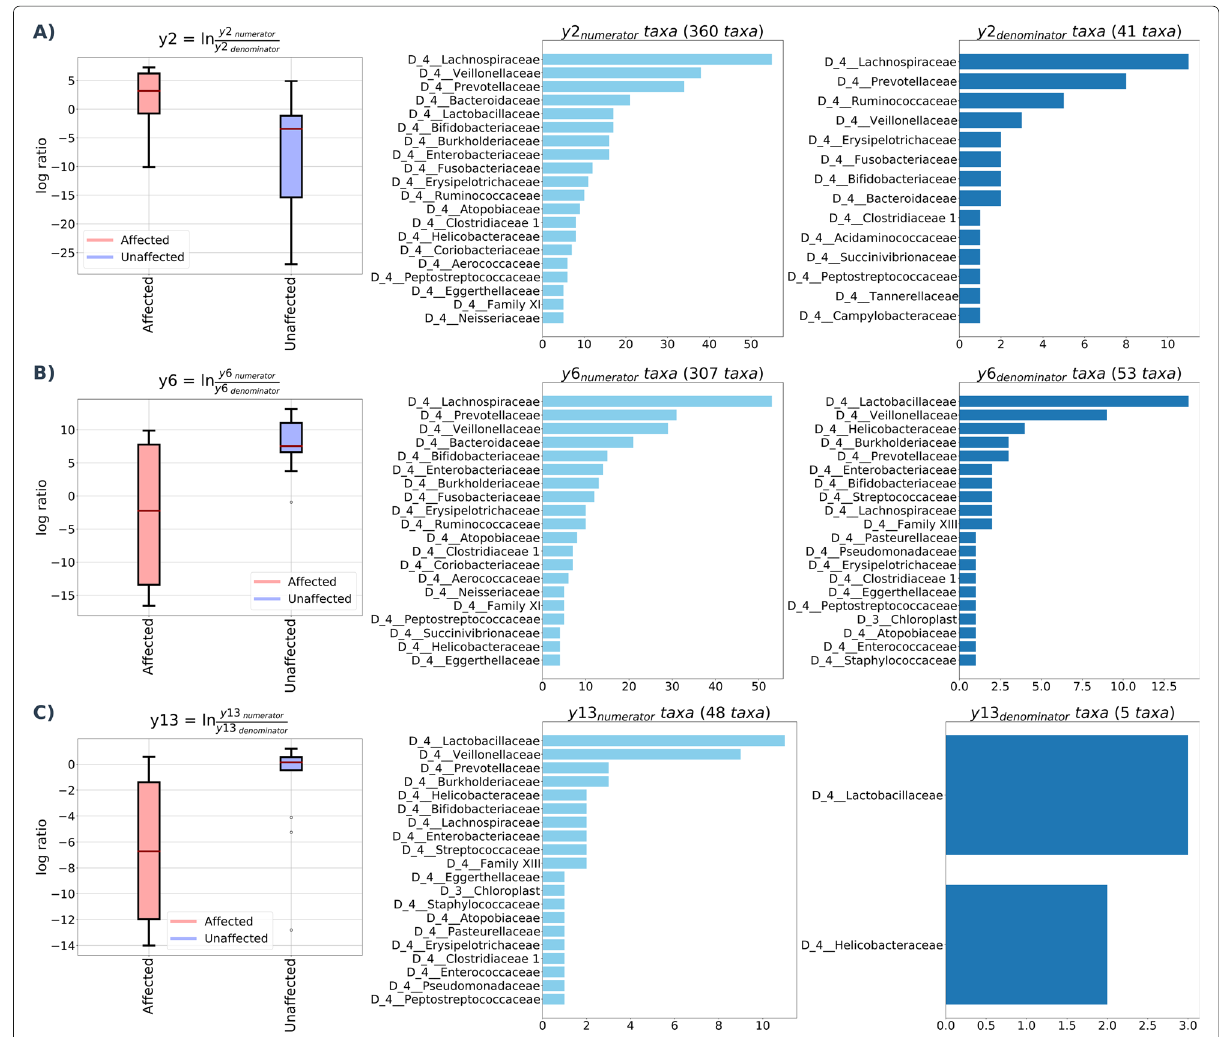
Fig. 3 Log ratios of balances significantly different between affected and unaffected tamarins. The log ratios of three balances were significantly different between affected and unaffected tamarins: y2 ( a ), y6 ( b ) and y13 ( c ). A lower log ratio suggests a shift towards denominator taxa while a higher log ratio suggests a shift towards numerator taxa. The dendrogram heatmap (Fig. 4) and taxa plots (Fig. 5) can be used in conjunction with significant balances to identify taxa which are responsible for differences in log ratio between disease